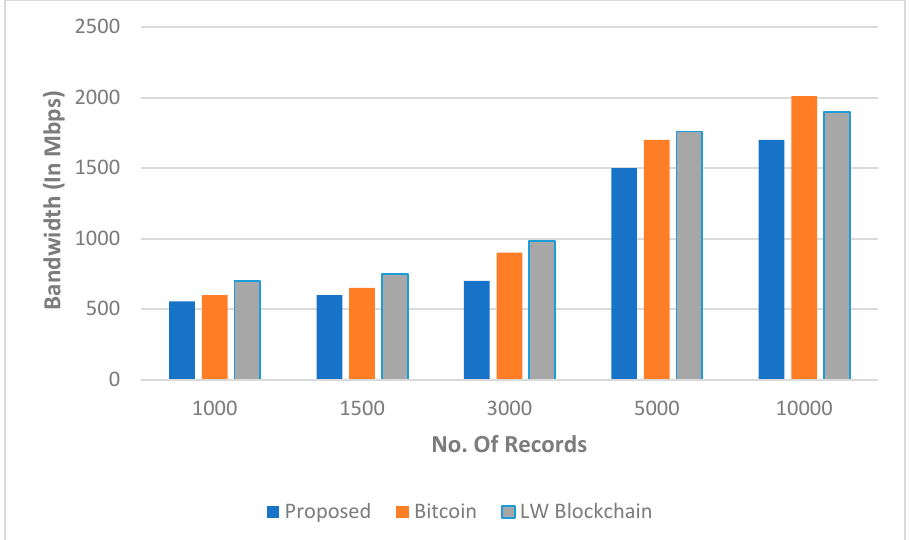
Figure 11. The simulated outcomes according to the bandwidth and number of iterations.